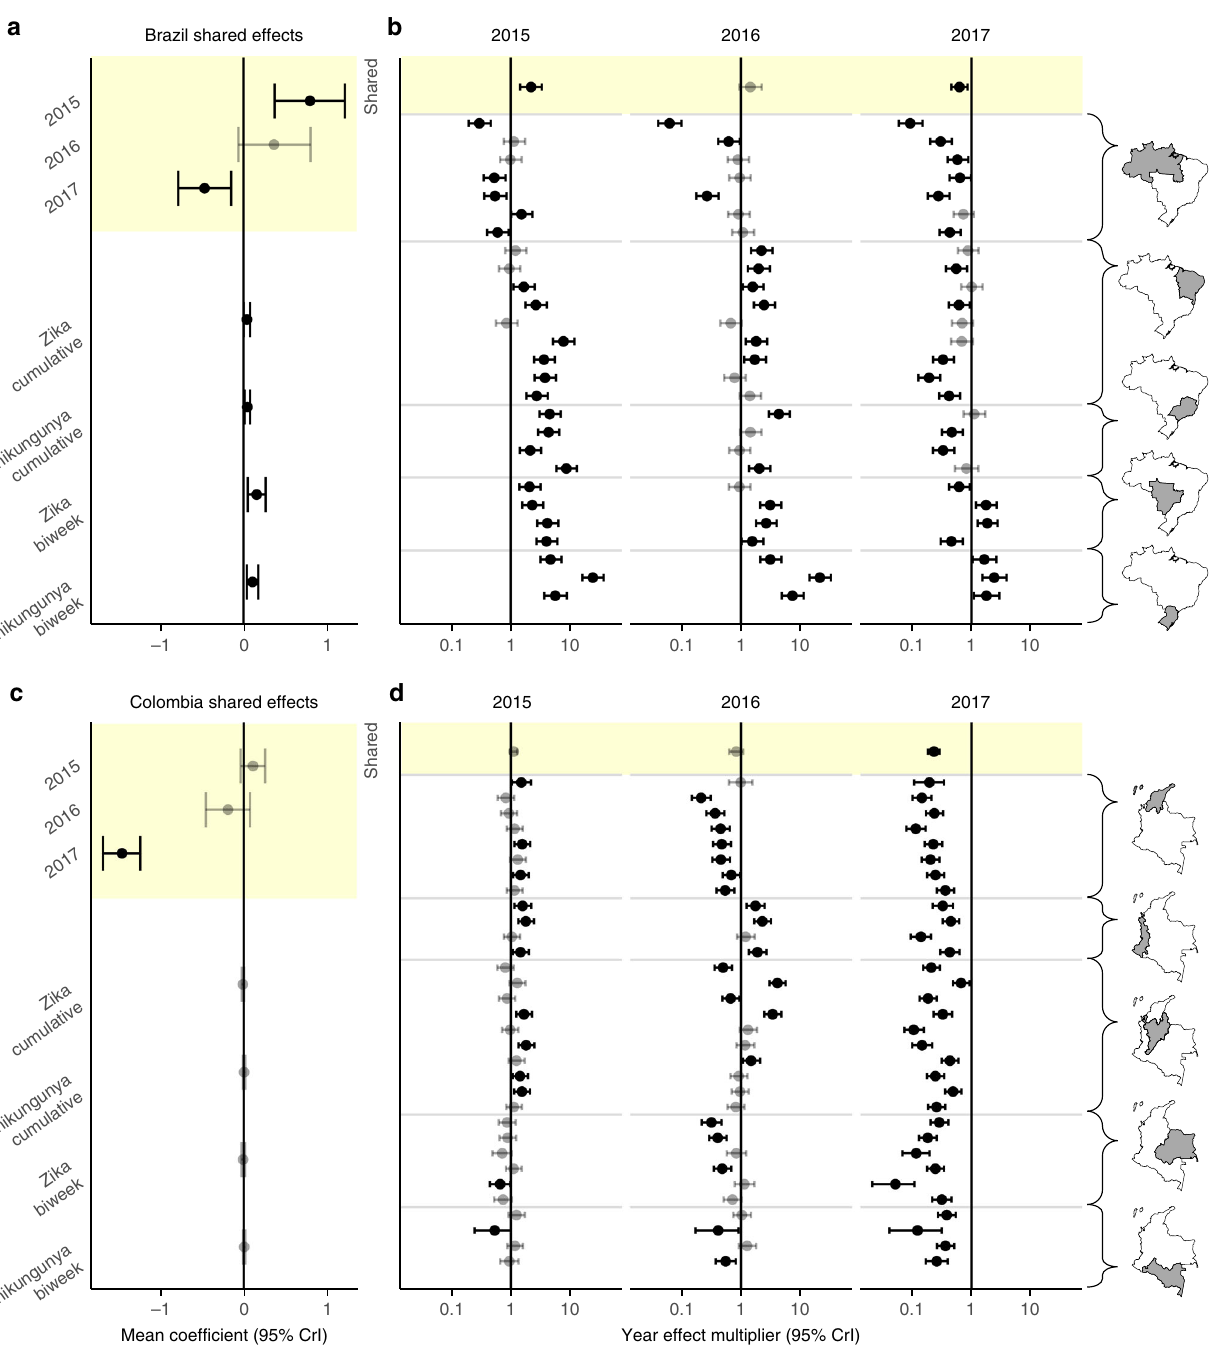
Fig. 3 Spatial hierarchical biweekly dengue incidence models. Shared coef fi cients from the year model are highlighted in yellow. Shared effect coef fi cients for Brazil ( a ) and Colombia ( c ). Zika and chikungunya coef fi cients are estimated from autoregressive dengue models. Positive (negative) coef fi cients indicate increases (decreases) in expected dengue incidence for the year model and indirectly as effects on transmission for the Zika and chikungunya models. Shared year multipliers for expected dengue incidence are shown for Brazil ( b ) and Colombia ( d ). The top row of panels b and d are translated from coef fi cients in ( a ) and ( c ). Other rows display subnational effects (combined shared and location-speci fi c effects). Mean and 95% credible intervals (CrI) are shown. Intervals that overlap zero are displayed in